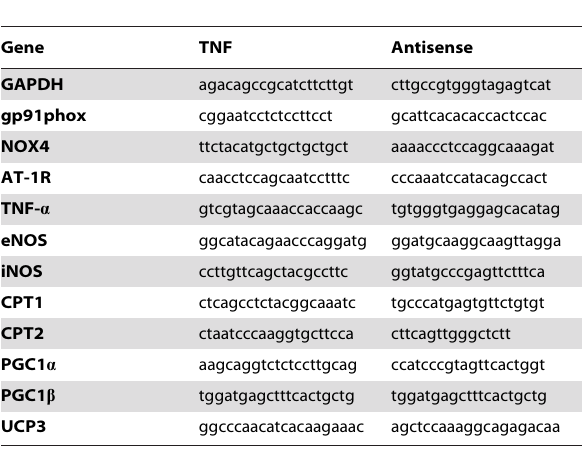
Table 1. Rat primers used for